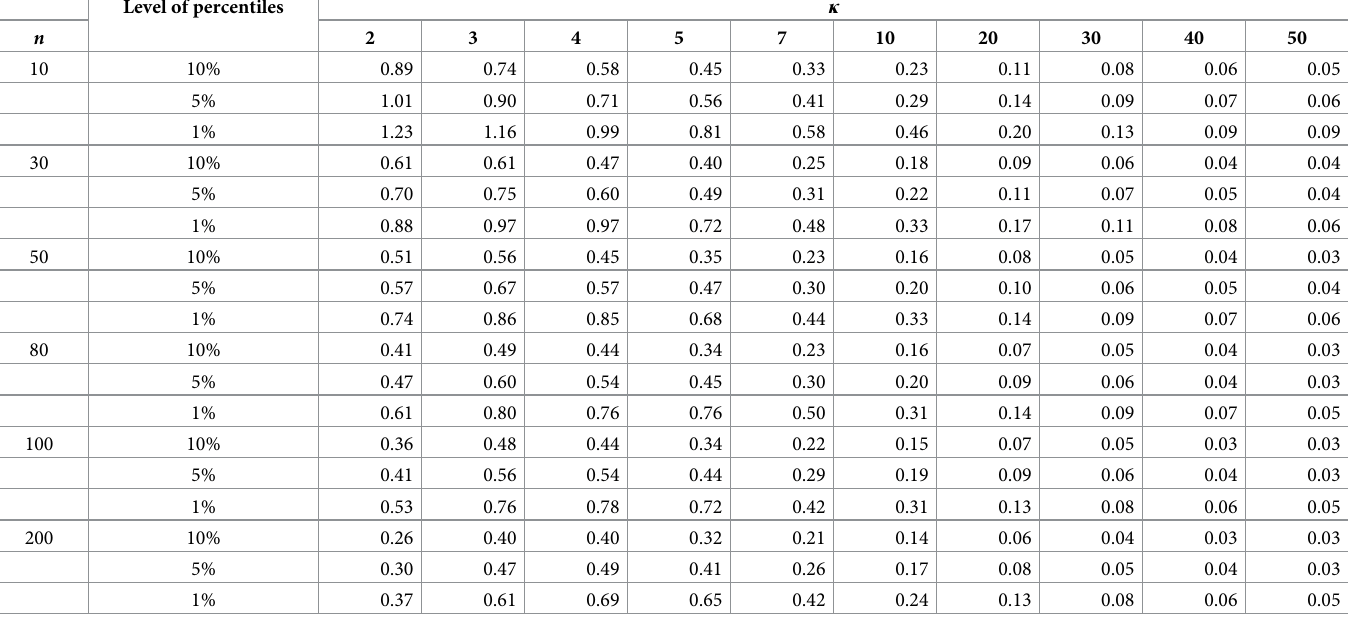
Table 1. Cut-off points, C Q for Q 1